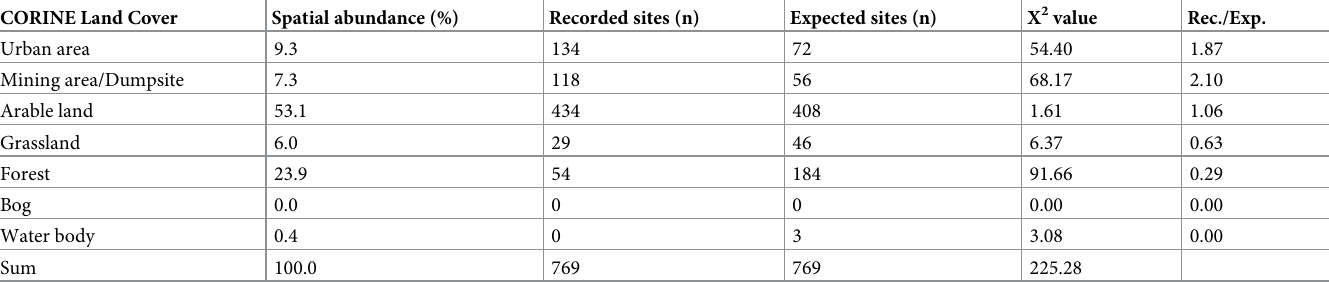
is recognisable. Further site concentrations can be described with the 1.5 km isolines near Zeitz, Eisenberg and north-east of Gera. These local concentrations are connected by the 2.5 km isoline which covers 87% of the Early Neolithic sites. Far outside these isolines there are isolated sites in the Central Uplands (Fig 8B). The majority of the Middle Neolithic sites is loosely scattered, so that the 1.5 km isoline can only cover about 57% of the sites and the 2.5 km isoline about 77%. A rather elongated concentration along the Weiße Elster valley and a small concentration near Zeitz are described. In addition, there are several isolated sites in a greater distance from the Weiße Elster valley. South of Zeitz there are only very few sites dating to the Middle Neolithic (Fig 8C). In comparison, the distribution of Late Neolithic sites covers a larger area than the Middle Neolithic. The 1.5 km isolines cover 67% of the Late Neolithic sites and describe several areas with a higher density: a large area along the Weiße Elster valley Table 2. Distribution of Neolithic sites over modern land